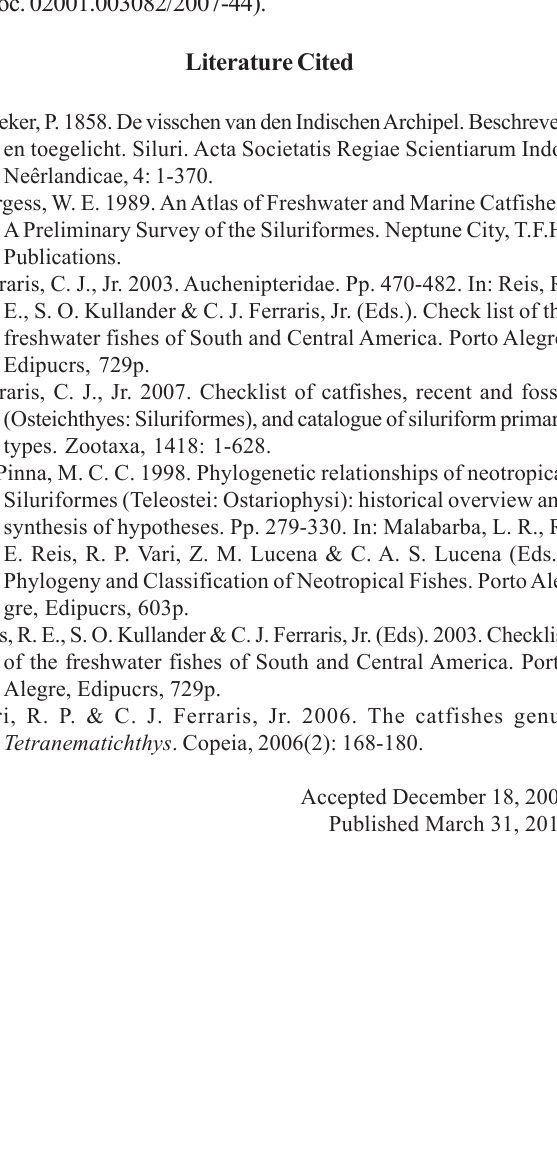
Fig. 5. Ventral view of head and anterior portion of (a) Tetranematichthys barthemi , holotype, male, MPEG 11081, 154.2 mm SL; and (b) Tetranematichthys quadrifilis , MPEG 6535, 127.2 mm SL, showing the difference between the alignments of the postorbital portion of